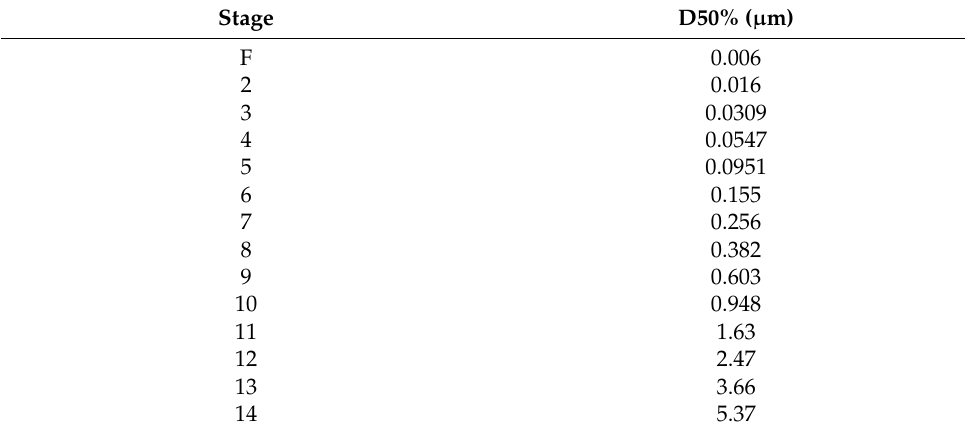
Table 1. Cut-off particle size (D50%) of each impactor